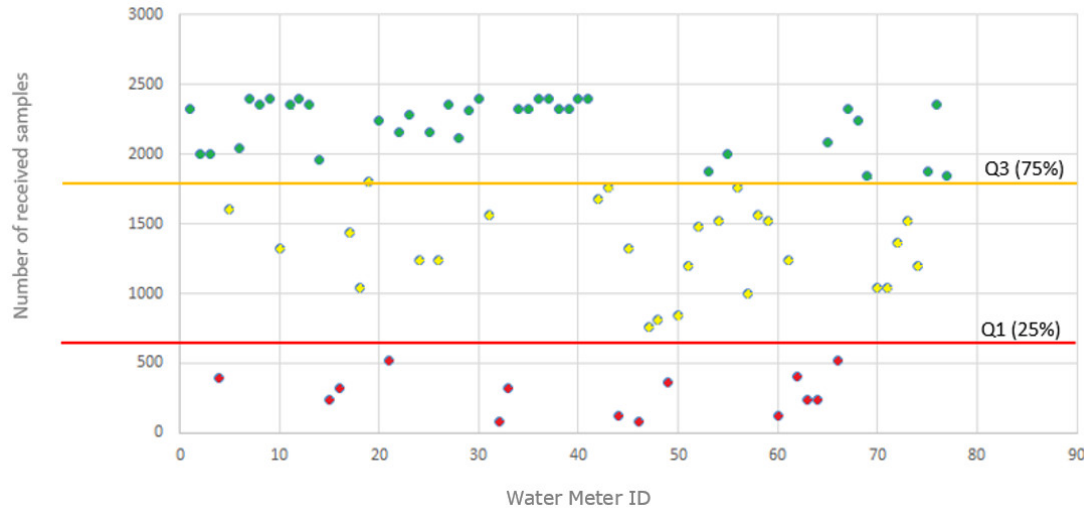
Figure 21. Number of samples received via radio (169 MHz ISM band) from 78 counters randomly selected from different areas of the city.